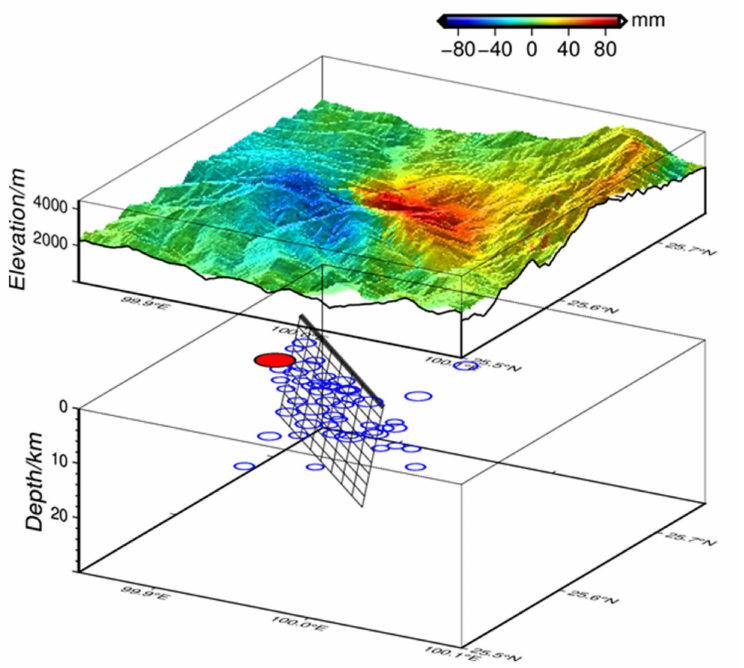
Figure 5. Three-dimensional location of fault. Upper: Coseismic deformation field from Sentinel-1 (descending track) superposed on the topography map. Lower: Fault model for inversion of coseimic slip distribution. Blue open circles represent aftershocks. The circle size is proportional to magnitude. Red solid circle represents the